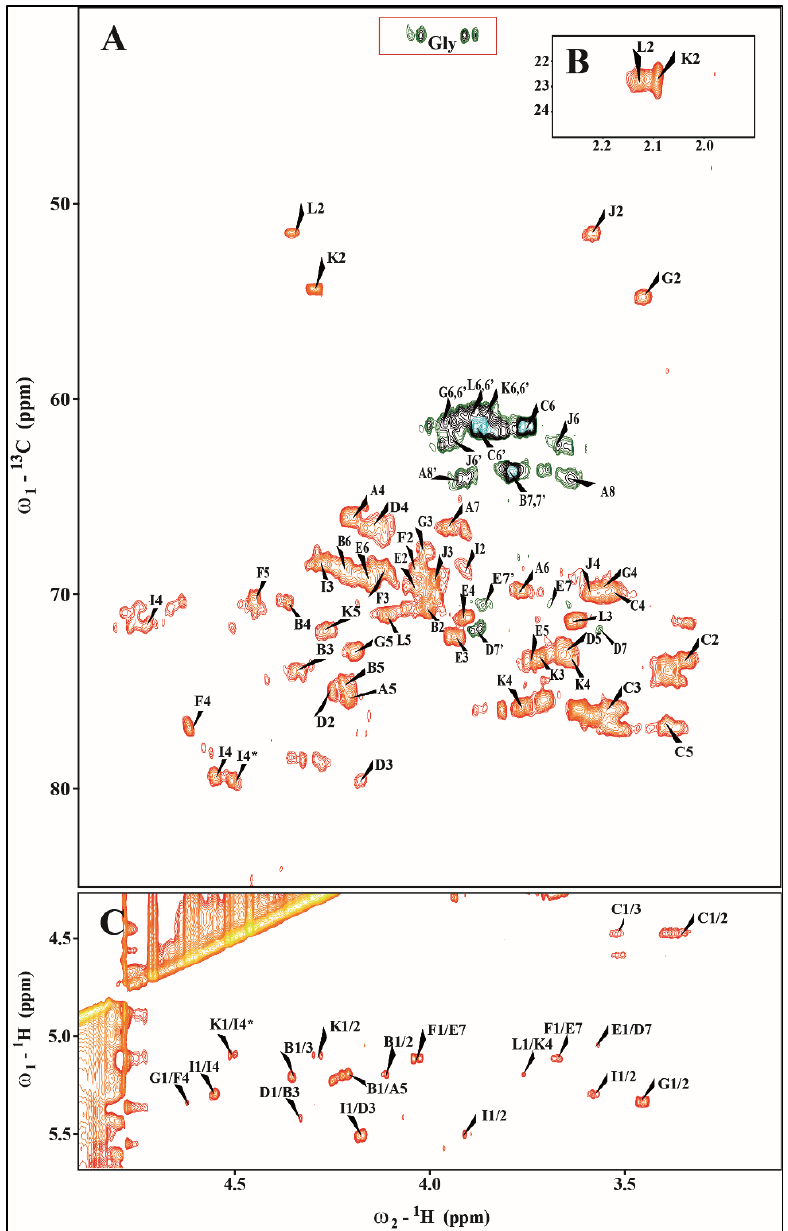
Figure 7. ( A , B ) Selected regions of the 1 H − 13 C HSQC-DEPT and ( C ) 1 H − 1 H NOESY spectra of the fraction OSVI of E. hoshinae DSMZ 13771 T core oligosaccharide. In the HSQC-DEPT spectra of OSVI (at δ H / δ C 3.92, 4.07/41.8 ppm), additional negative CH 2 signals were detected. These resonances showed a correlation with carbonyl carbon signals at δ C 168.1 ppm in the HMBC spectra, suggesting the presence of glycine. The 1 H − 1 H NOESY spectrum showed strong inter-residue cross-peaks between the following transglycosidic protons: H − 1 of B /H − 5 of A , H − 1 of D /H − 3 of B , H − 1 of E /H − 7 of D , H − 1 of F /H − 7 of E , H − 1 of G /H − 4 of F , H − 1 of I /H − 3 of D , H − 1 of J /H − 4 of I , H − 1 of K /H − 4 I , H − 1 of L /H − 4 of K . The linkage between H − 1 of C /H − 4 of B was not observed. Despite this the HMBC spectrum of OSVI confirmed the substitution positions of all monosaccharide residues. The cross-peaks between H − 1 of K /H − 4 of I , and H − 1 of J /H − 4 of I showed heterogeneity due to the presence of a